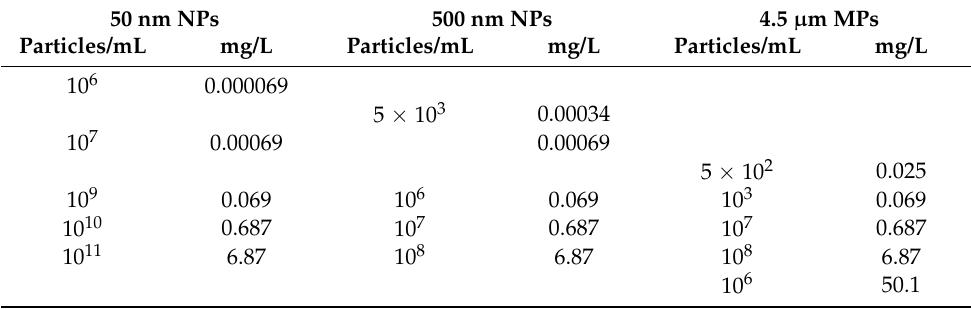
Table 1. Relationship between the plastic particle concentrations, in terms of mass and in terms of number of particles for the three sizes